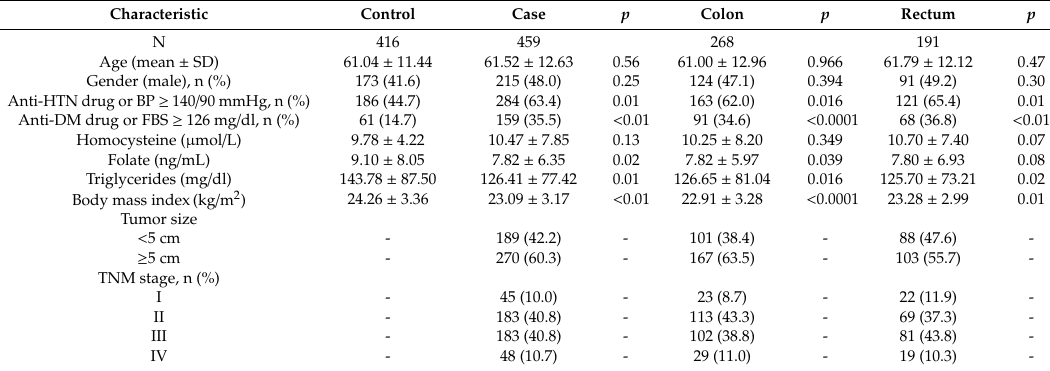
Table 1. Baseline characteristics of colorectal cancer patients and control